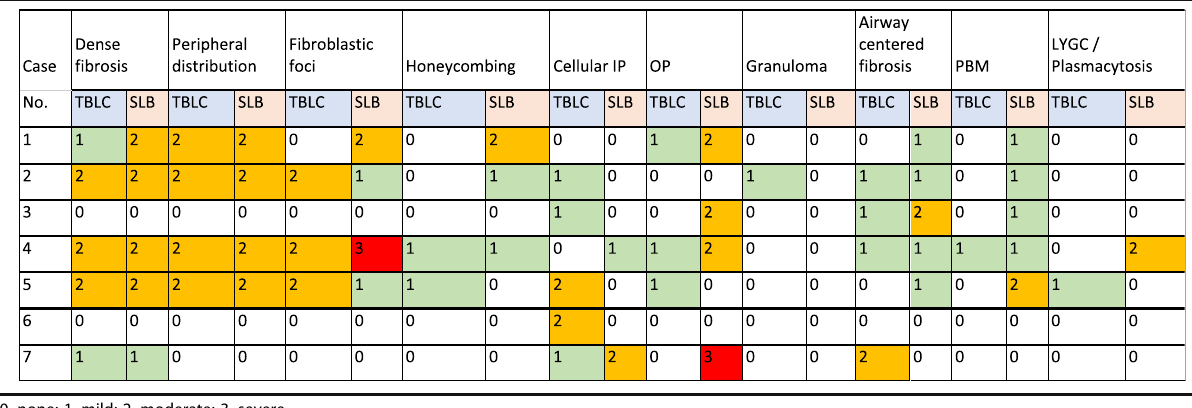
Table 3 Pathological findings in all 7 cases